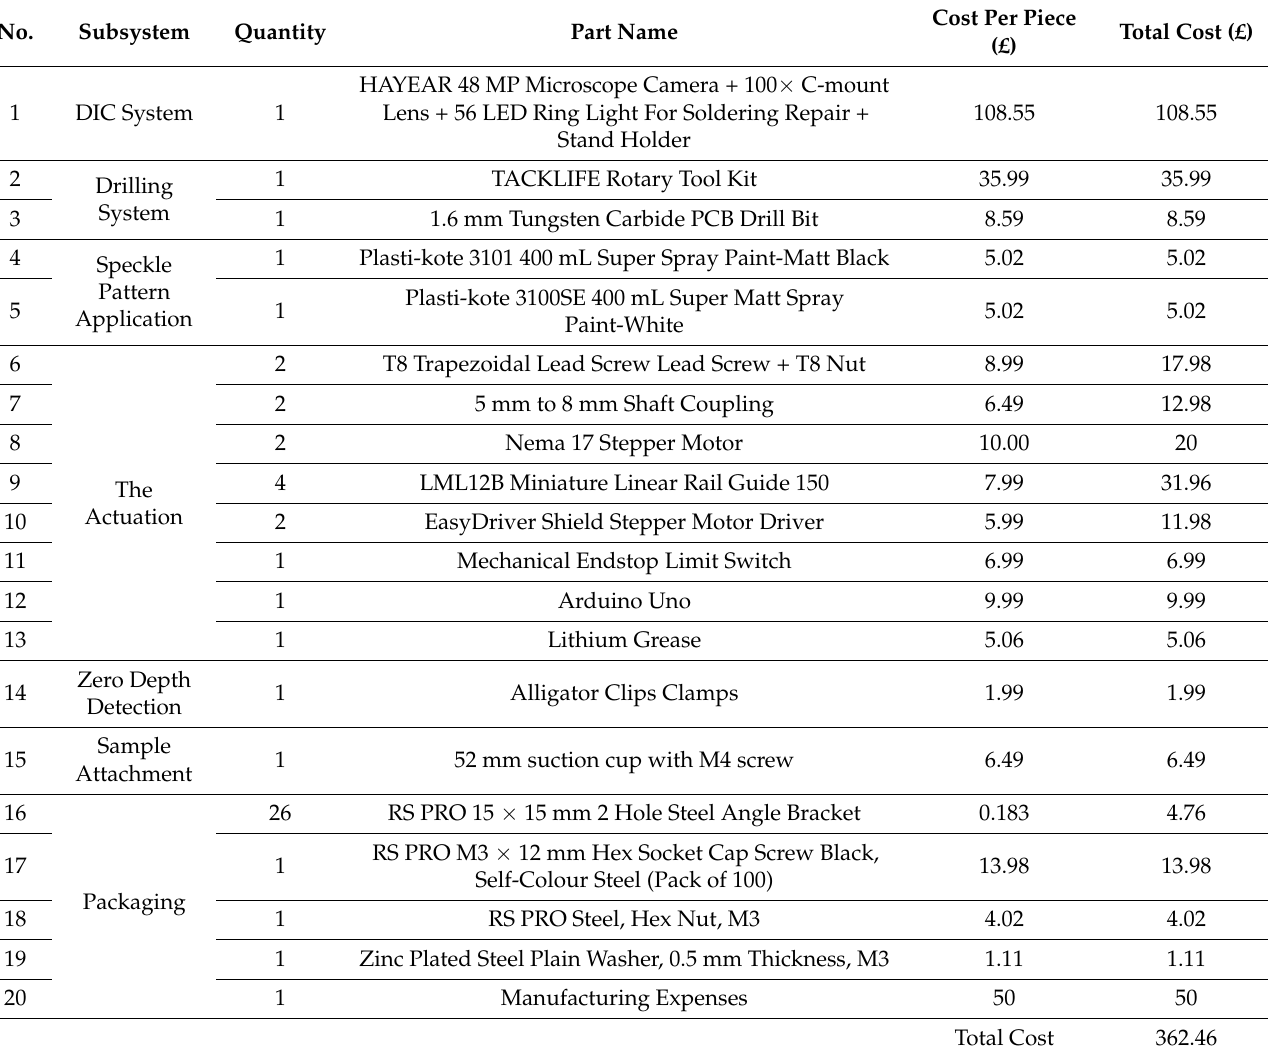
Table 4. Key components used in the measurement device and their